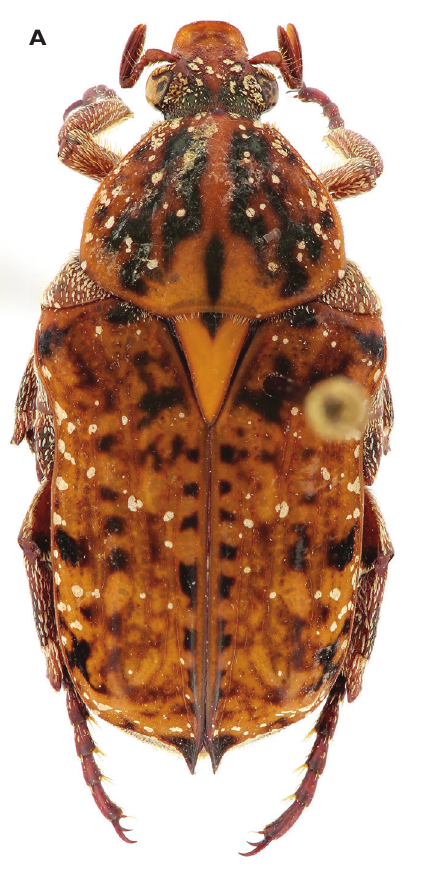
Figure 14. Atrichelaphinis ( Eugeaphinis ) garnieri sp. n., paratype male, Zimbabwe (MNHN). A Dorsal view B parameres in dorsal